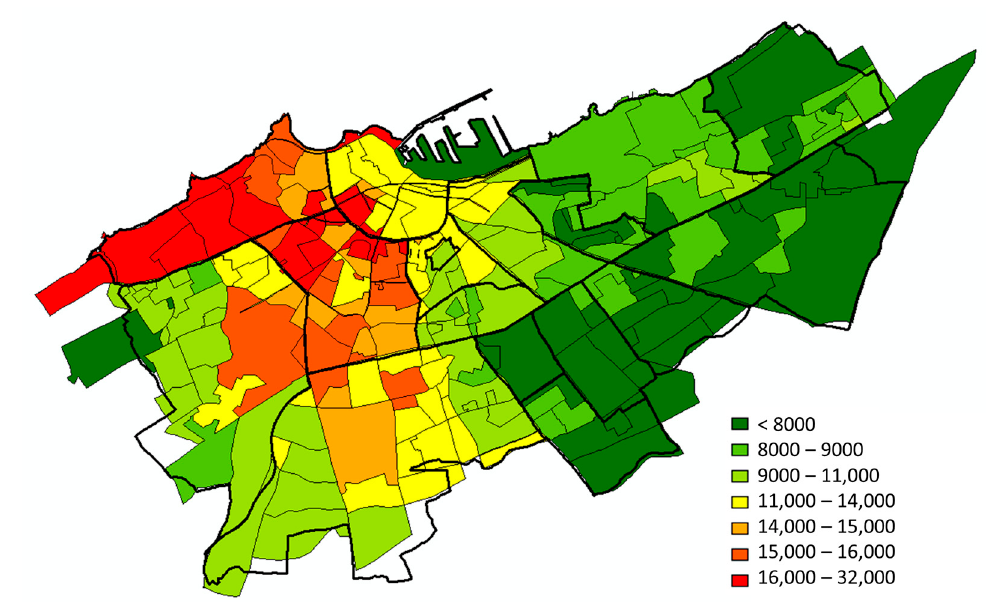
Figure 16. Apartment price in MAD/m 2 .